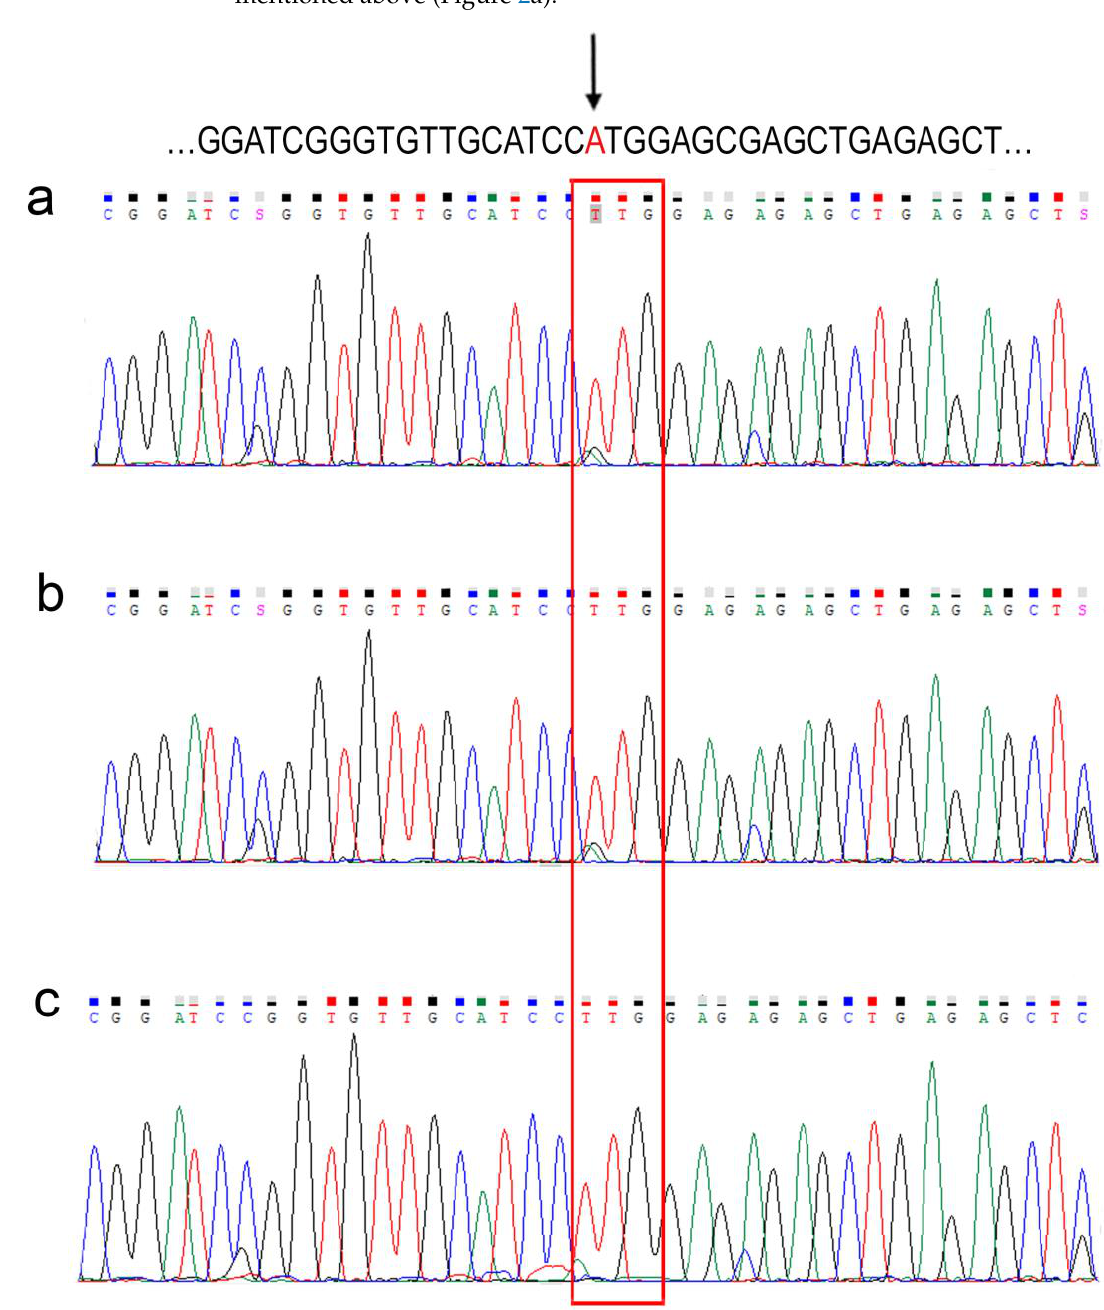
Figure 2. Molecular diagnosis of the variant c.1A > T, (p.Met1Leu) in PMS2. Up sequence reference NG_008466.1. Sequencing chromatograms for ( a ) index patient; ( b ) family extension; and ( c ) healthy volunteer. Arrow indicates c.1A > T, (p.Met1Leu) in PMS2 ; the red rectangle marks the change region c.1A > T,